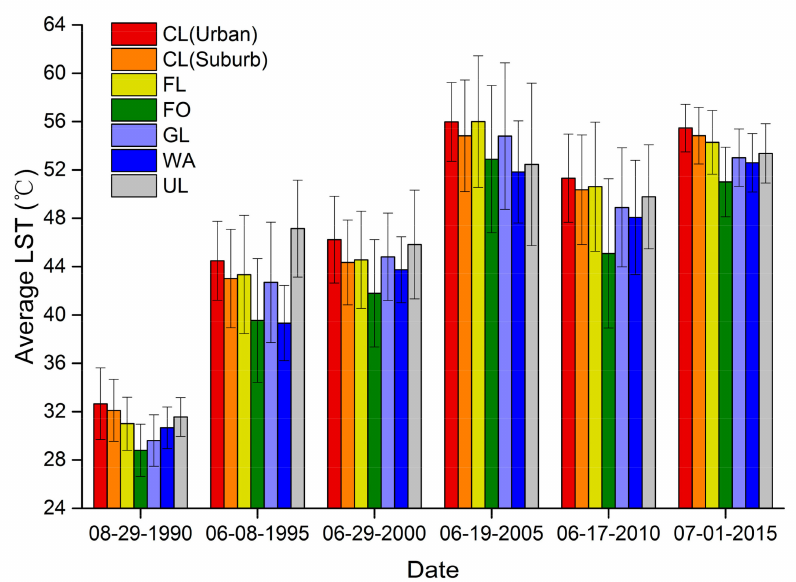
Figure 4. Comparison of the average LST among different LULC types and different regions (urban area of Yan’an city, and suburban area of Yan’an city) during six periods from 1990 to 2015 (error bars represent the standard deviation in the corresponding average